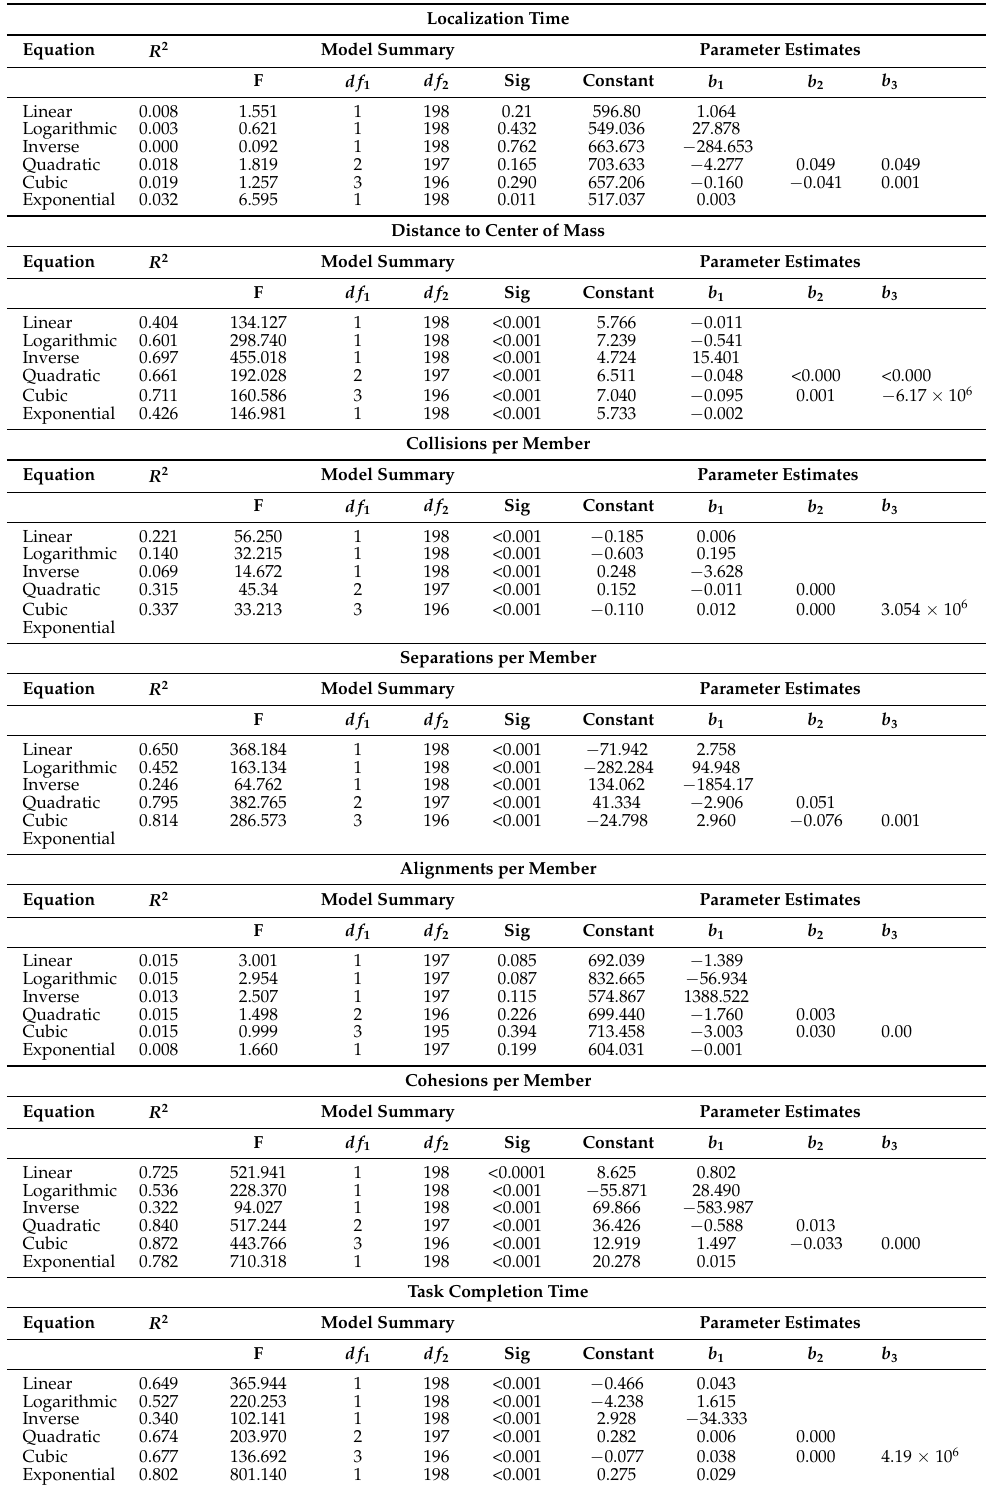
Table A5. Model summary and parameter estimates for the curve fitting obtained in experiments without obstacles for each of the nine flocking performance measures, showing five equations (linear, inverse, logarithmic, quadratic, cubic, and exponential), where the independent variable is the flock size and the dependent variable is each performance measure,